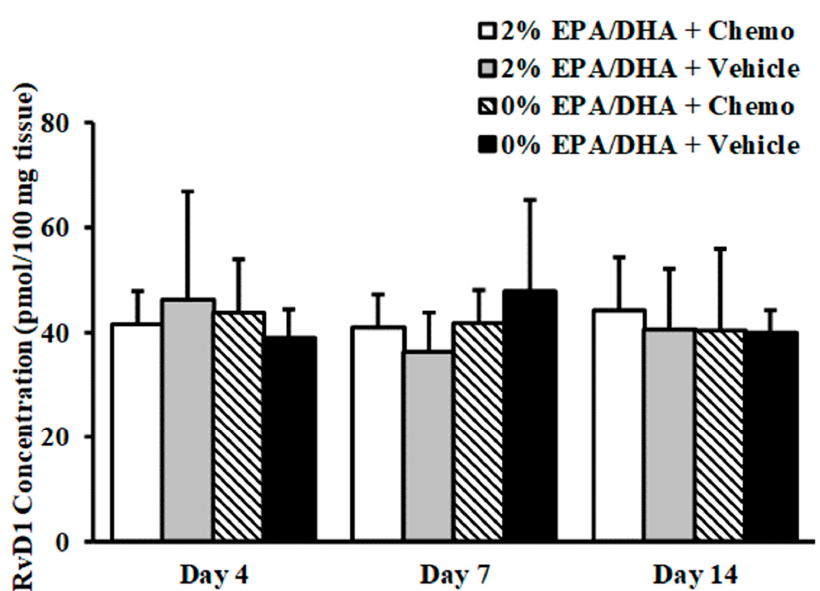
Figure 1. Concentrations of RvD1 in brain tissue extract in animals sacrificed 4, 7, and 14 days after the last chemotherapy or vehicle treatment, ( n = 8–12 for each group) represented as means ± standard error of the mean. There was no main effect of diet supplementation, chemotherapy group, nor day on RvD1 levels ( P > 0.05). Chemo = DOX (9 mg/kg) + cyclophosphamide (90 mg/kg) treatment.